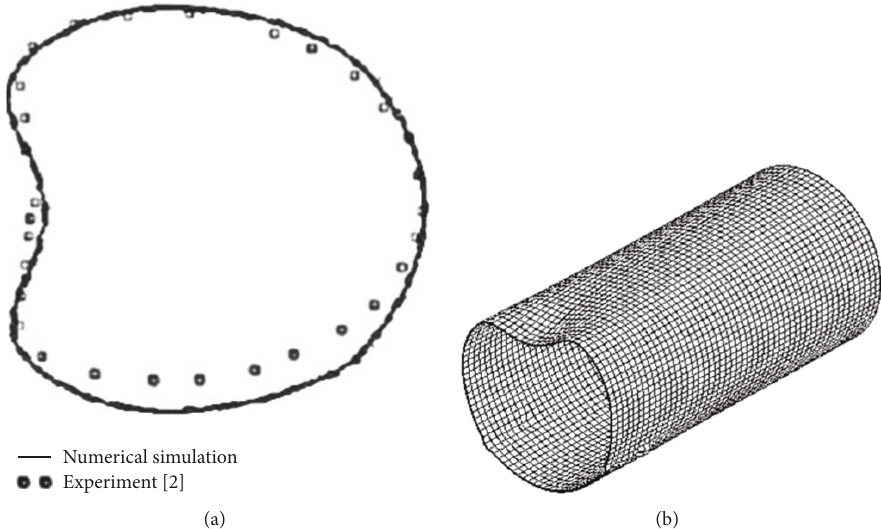
Figure 4: (a) Middle section of the cylindrical shell UNDEX blasted from the left side; comparison between the present numerical simulation and experiment [2]; (b) 3D caption, 10g charge weight.